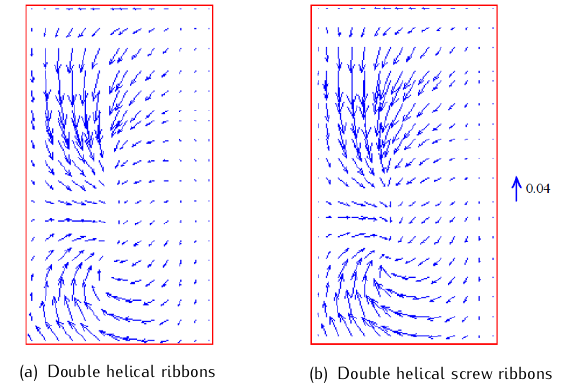
Figure 5. Flows patterns induced in r-z plane defined by